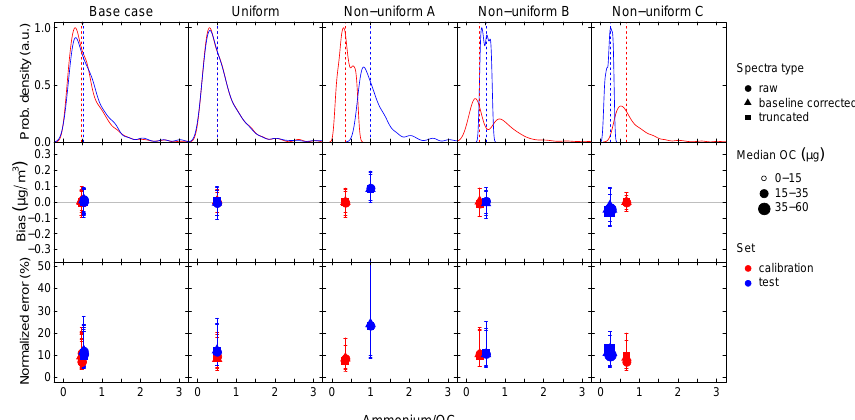
Figure 6. The probability distribution of ammonium / OC and bias and normalized error (with the interquartile range shown by error bars) in the calibration (red) and test (blue) sets for five calibration cases: the Base case, the Uniform ammonium / OC case and three Non-uniform ammonium / OC cases. Vertical lines on the probability distributions are the median of the ammonium / OC distributions.